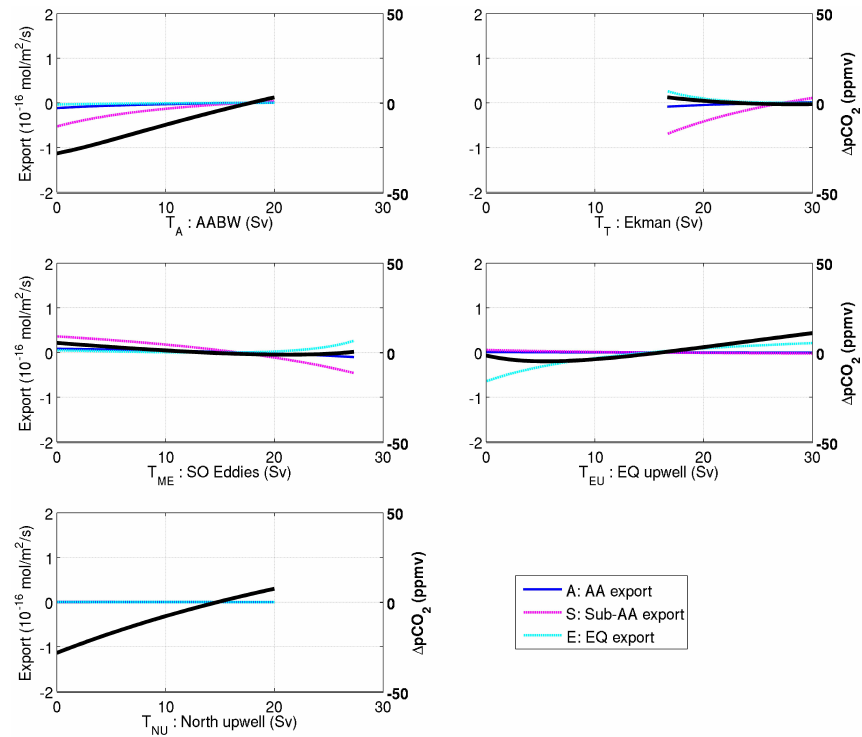
Fig. 5. The response of atmospheric 1p CO 2 (solid black), Antarctic export production (from box A, solid dark blue), Sub-Antarctic export production (from box S, dashed magneta), and Equatorial export production (from box E, dashed light blue) to the five circulation input parameters, T A , T T , T ME , T EU , and T NU . The export fluxes (left axis) and 1p CO 2 (right axis) are expressed as the difference from that of the best fit interglacial